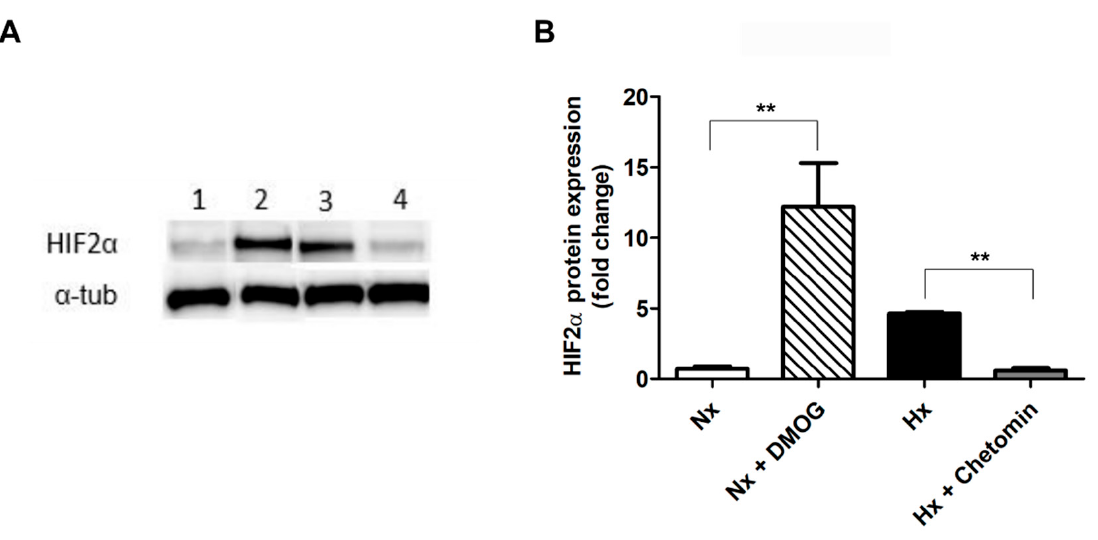
Figure 1. Expression of HIF2 α protein is increased under hypoxic conditions. ( A ) GSCs were cul- tured under different conditions, and the HIF2 α expression was analyzed by Western blot in total cell lysates (a representative image is shown). 1: normoxia; 2: normoxia + DMOG; 3: hypoxia; 4: hypoxia + chetomin. ( B ) Image band quantification by using ImageJ analysis software. Nx: normoxia; Hx: hypoxia. Data were normalized to α -tubulin levels. ** p < 0.01. Bars represent mean ± SEM of three independent experiments.